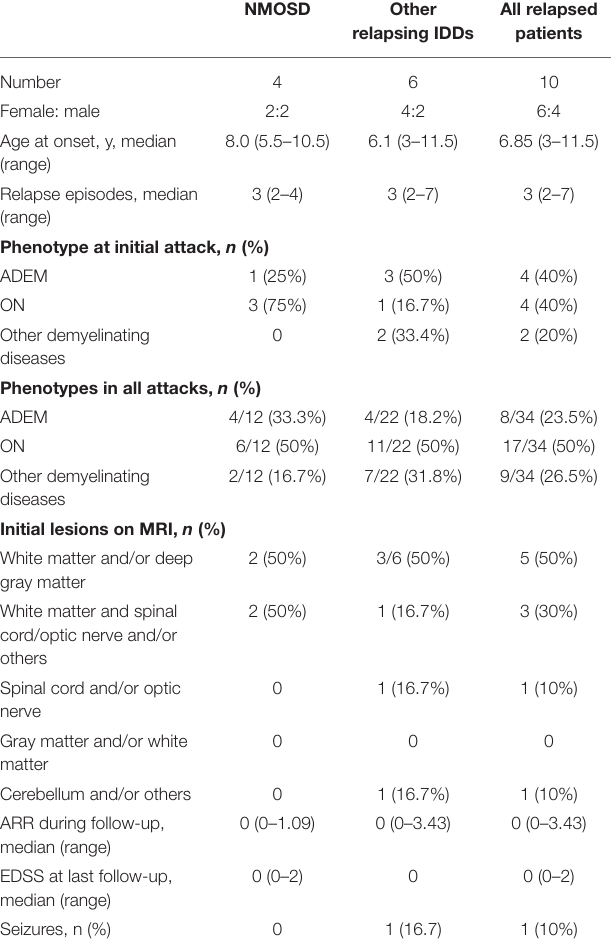
TABLE 5 | Comparison between patients with NMOSD and those with other relapsing IDDs.